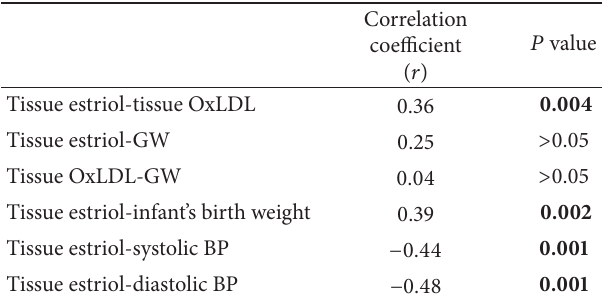
Table 4: Correlation coefficients of tissue markers and clinical data ( 𝑛 = 62